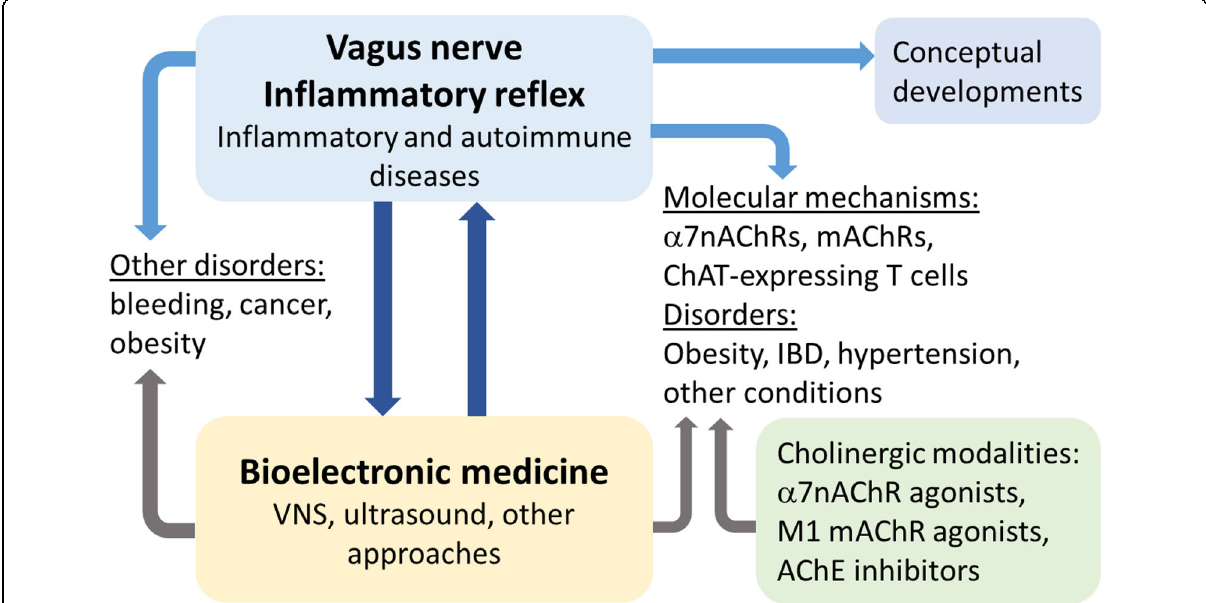
Fig. 2 The immunoregulatory functions of the vagus nerve in bioelectronic medicine and associated insights and advances. Preclinical studies on the immunoregulatory role of the vagus nerve and the inflammatory reflex in the context of inflammatory and autoimmune diseases have resulted in successful clinical trials exploring implanted device-generated VNS in Crohn ’ s disease and rheumatoid arthritis under the umbrella of bioelectronic medicine. There is a symbiotic relationship between these and other ongoing clinical studies and active preclinical research. Studies stemming from this research have identified vagus nerve regulatory functions in bleeding, cancer, obesity and other disorders, which can also be targeted for therapeutic benefit by bioelectronic approaches. Molecular and cellular mechanisms underlying the inflammatory reflex involve α 7nAChRs, brain mAChR and ChAT-expressing T lymphocytes. Their role as molecular therapeutic targets has been indicated in obesity-associated disorders, IBD (colitis), hypertensive and hypotensive conditions and other disorders, which can be targeted for therapeutic benefit by α 7nAChR agonists, centrally- acting M1 mAChR agonists and AChE inhibitors and bioelectronics. All of this research, technological advances and therapeutic approaches have been accompanied by charting new relevant concepts and their ongoing validation (See text for